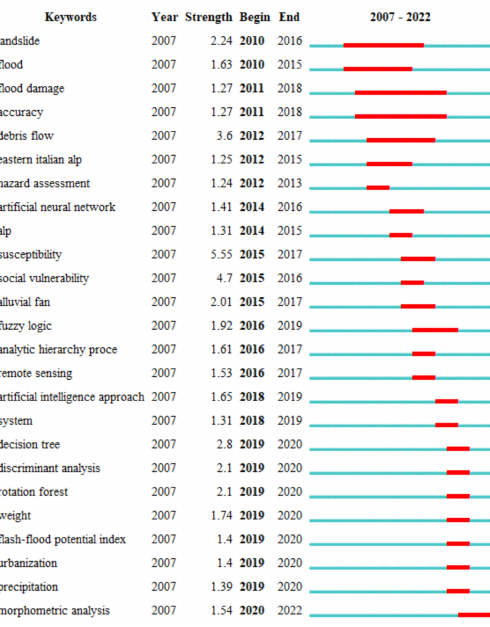
Figure 8. Top 25 keywords with the strongest citation